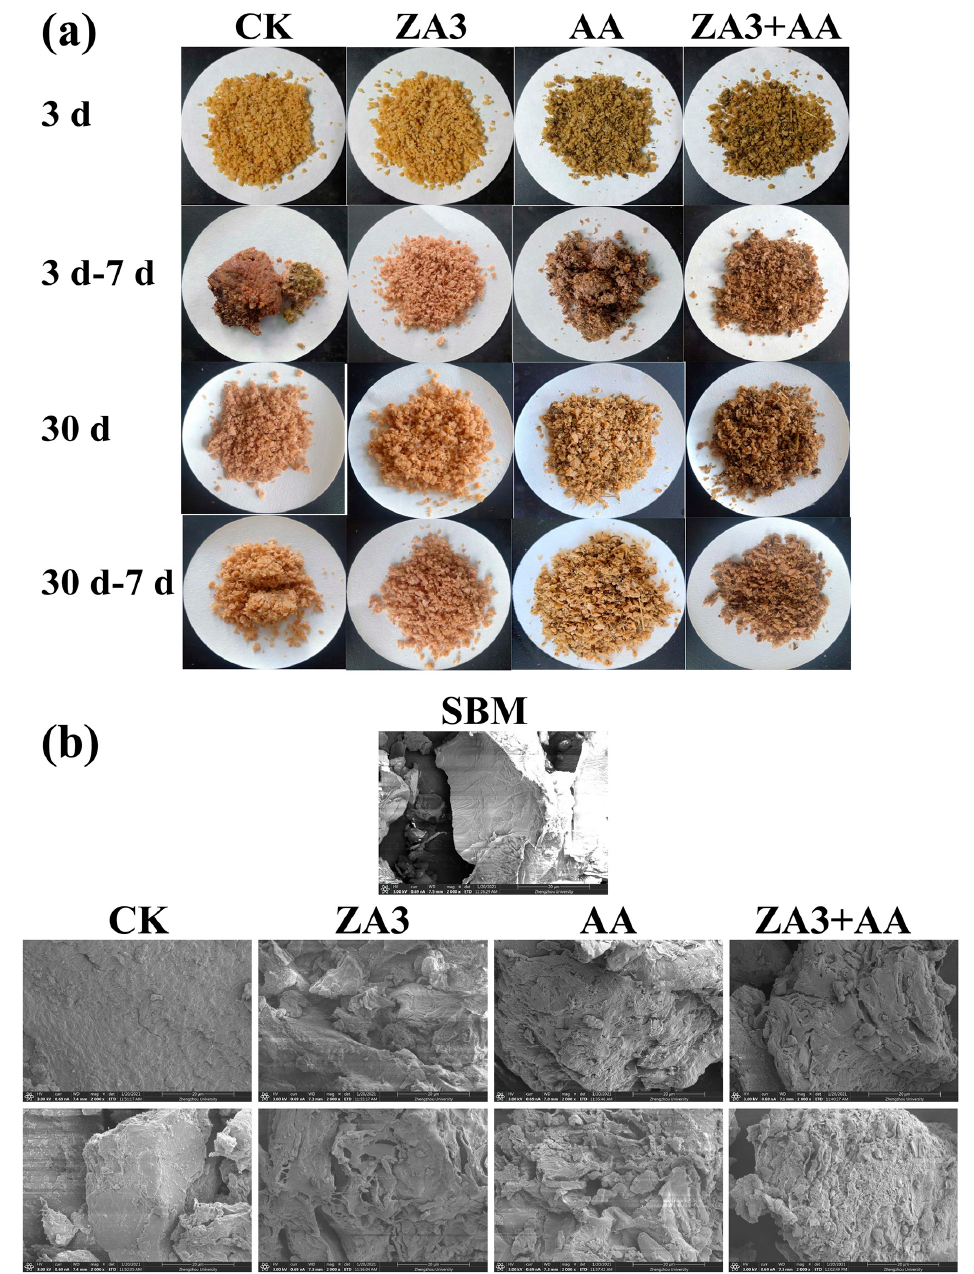
Figure 1. Sensory evaluation and surface structure of FSBM during fermentation and aerobic exposure. ( a ) The appearance of FSBM after 3 and 30 d fermentation and 7 d exposure after these two stages, ( b ) SEM images after 3 d and 30 d at × 2000-fold magnification. d,